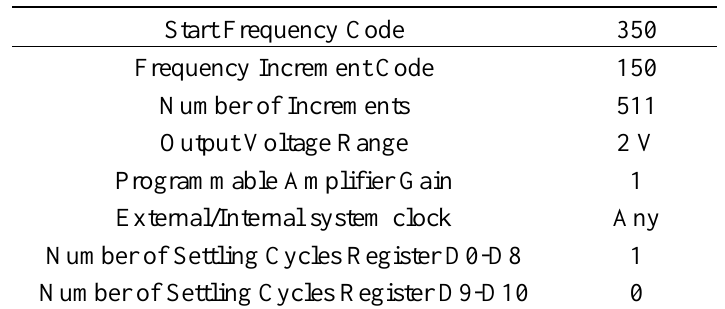
Table 2. Sweep parameters.